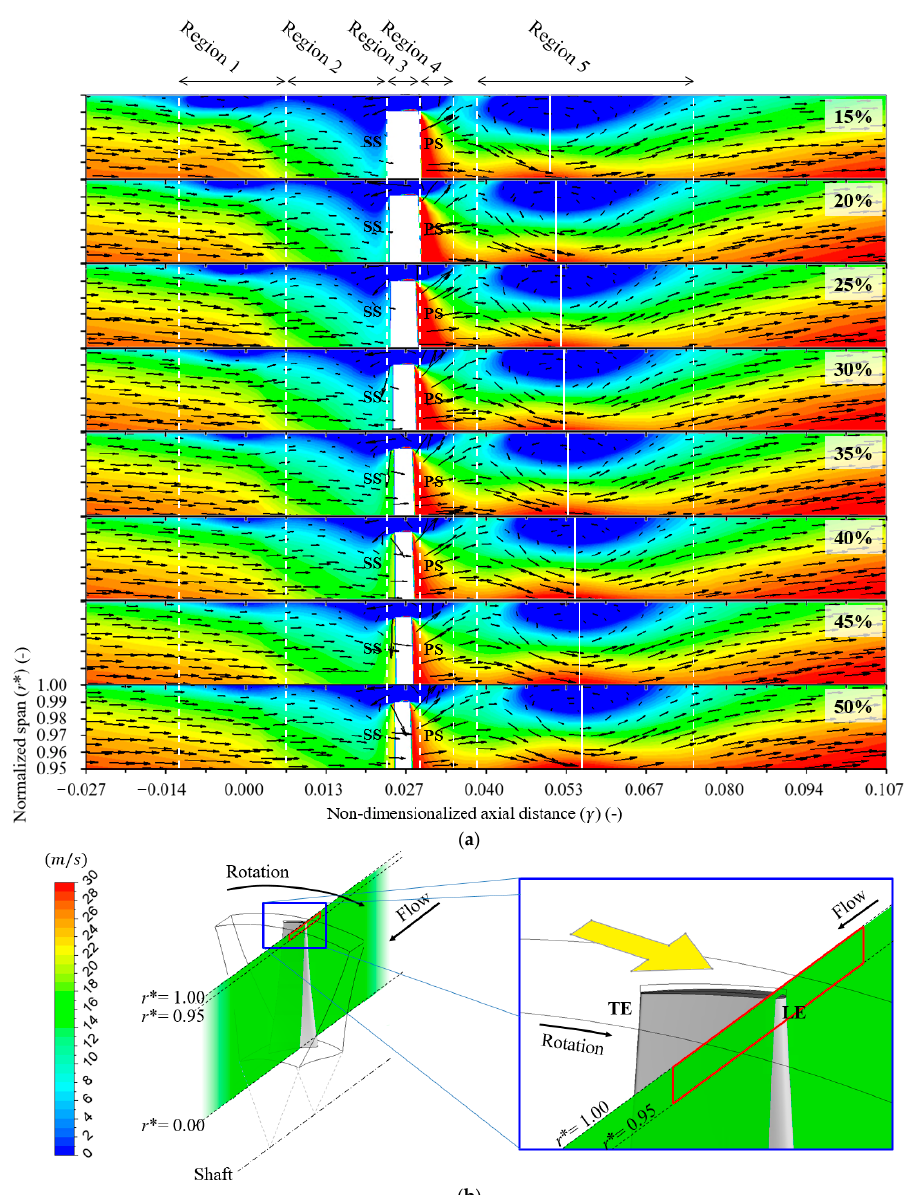
Figure 19. ( a ) Axial velocity contour and flow vector with different maximum thickness positions on ( b ) the observation plane ( Φ / Φ des =